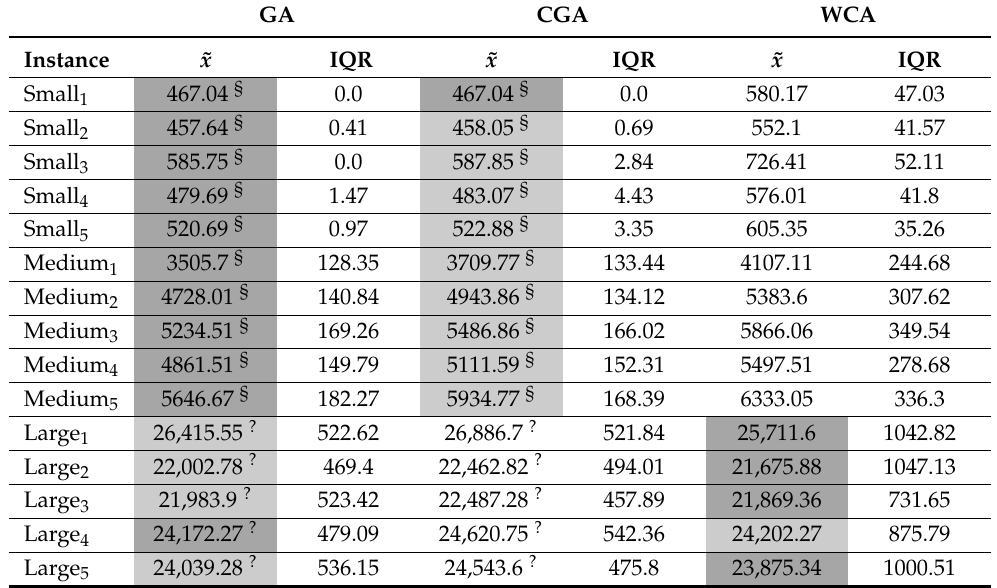
Table 6. Median and IQR of the GA, CGA, and RS over 100 independent runs. Dark and light gray emphasize the best and second-best results,